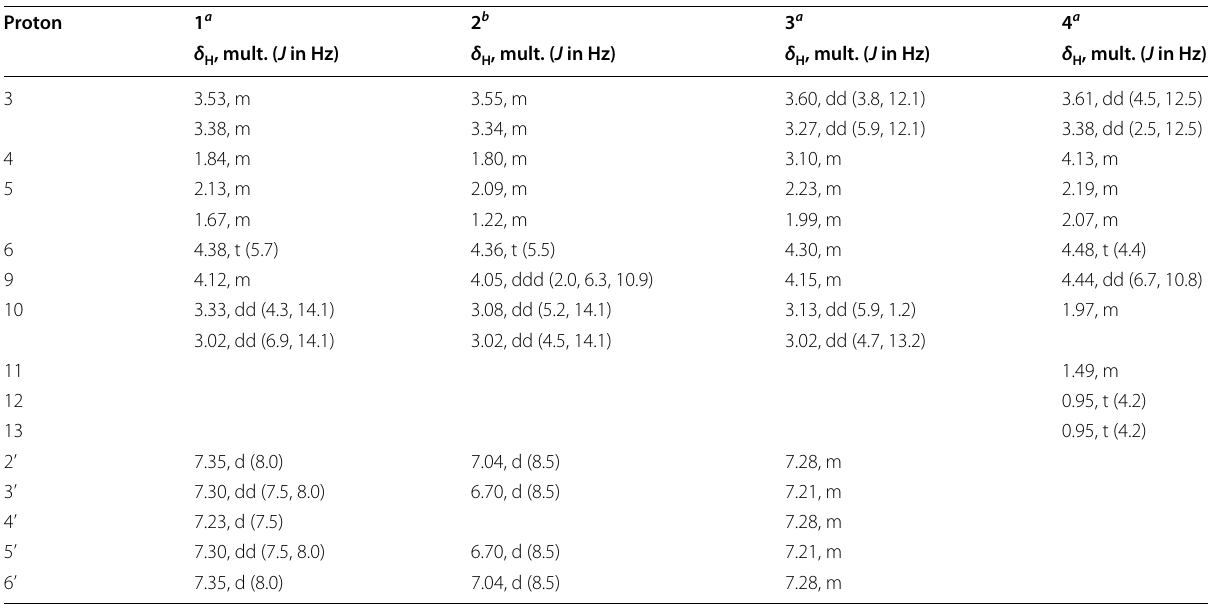
Table 4 1 H NMR data (500 MHz) of compounds 1 –